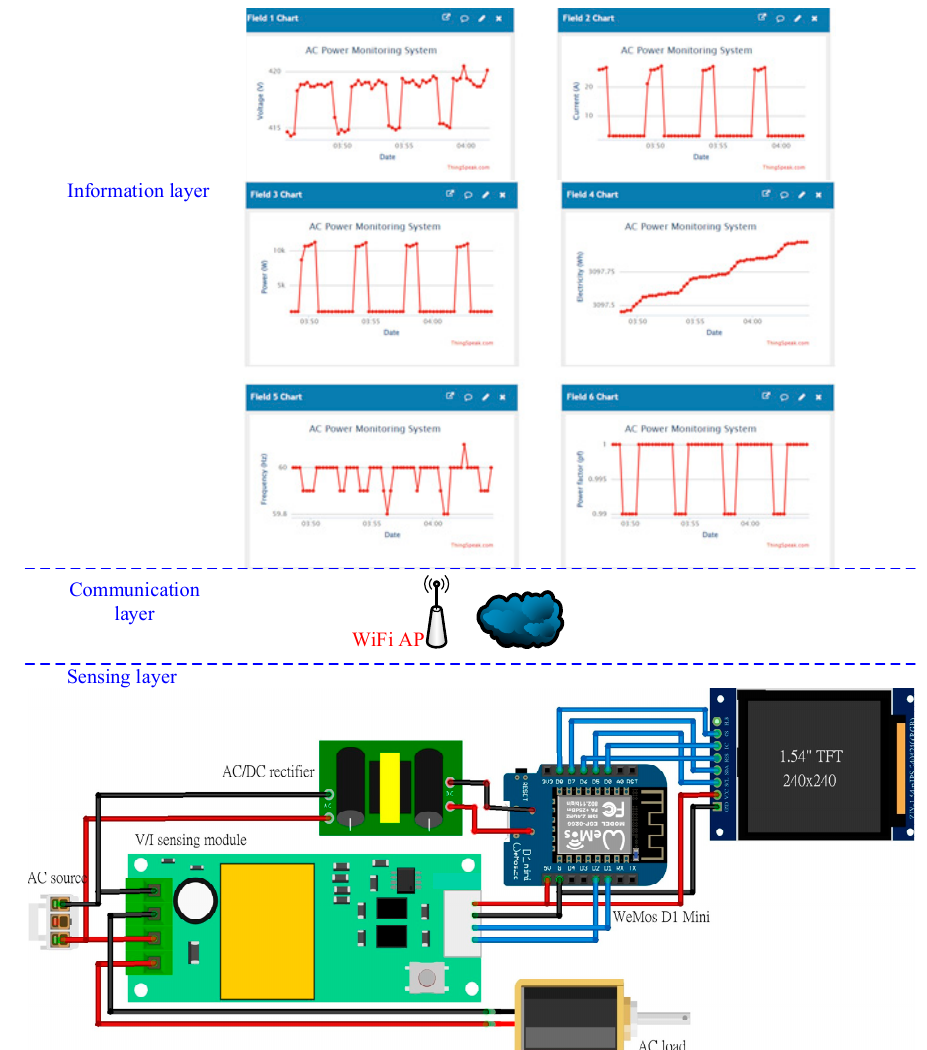
Figure 2. Schematic of proposed AC power monitoring IoT System.